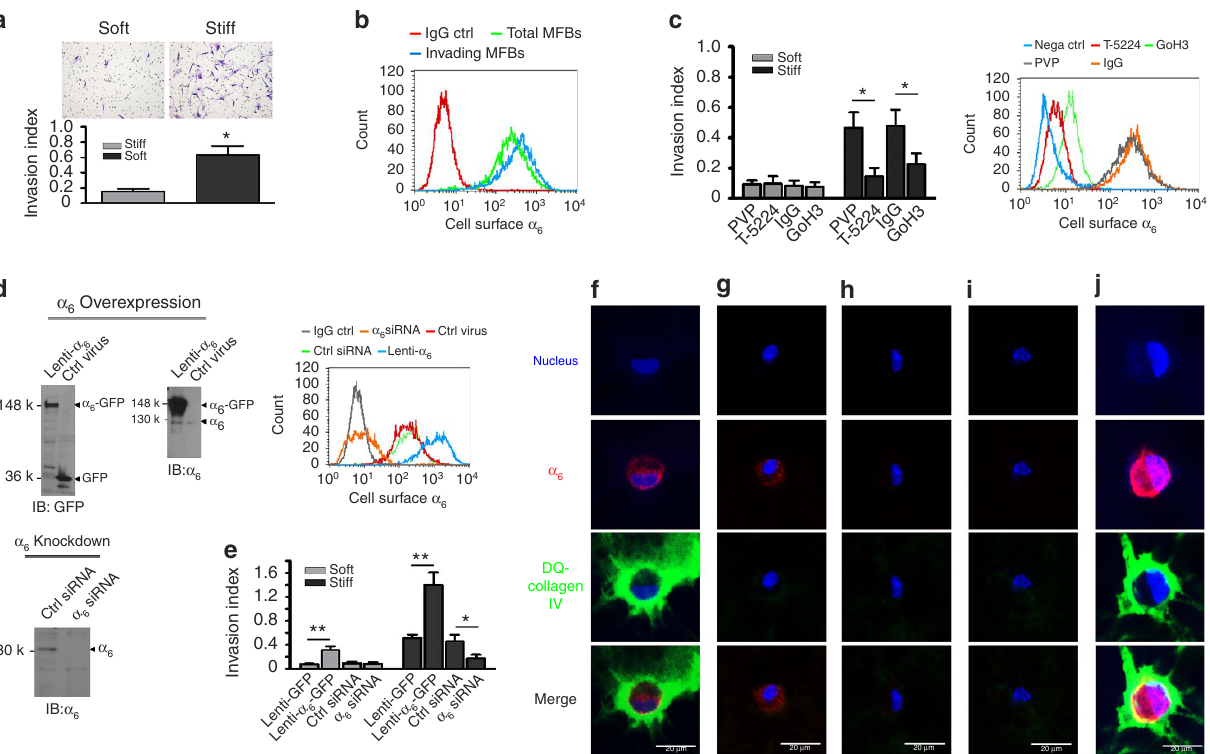
Figure 2 | a 6 Mediates matrix stiffness-dependent lung myofibroblast invasion into the BM. ( a ) The ability of IPF myofibroblasts cultured on soft versus stiff matrix to invade the BM was evaluated by Matrigel invasion assay. ( b ) a 6 -Expression on the cell surface of invading myofibroblasts versus total (myo)fibroblasts was evaluated by flow cytometry. ( c ) Effects of NKI-GoH3 and T-5224 on stiffness-regulated myofibroblast invasion into the BM. a 6 -Expression on the cell surface was evaluated by flow cytometry using FITC-labelled GoH3. PVP, a vehicle for T-5224; IgG, FITC-labelled isotype control IgG for NKI-GoH3; Nega ctrl, plain cells with no treatments and no incubation with FITC-labelled GoH3/IgG. ( d ) Overexpression of a 6 -GFP fusion protein by lentivirus and knockdown of a 6 by siRNA in cell lysates were determined by immunoblot and flow cytometry. ( e ) Effects of overexpression or knockdown of a 6 on stiffness-regulated myofibroblast invasion into the BM. ( f – j ) a 6 -expression (red) and proteolytic activation of DQ-collagen IV (green) in the absence ( f ) or presence of NKI-GoH3 ( g ), T-5224 ( h ), a 6 -siRNA ( i ) and Lenti- a 6 ( j ) were determined by confocal immunofluorescent microscopy. Nuclei (blue) were stained by DAPI. Results are the means ± s.d. of at least three separate experiments; * P o 0.05, ** P o 0.01; one-way analysis of variance. Scale bar, 20 m (Fig. 2g), inhibition of mechano-induction of a 6 -expression Fig. 5c) and IPF lung myofibroblast invasion into BM matrices by T-5224 (Fig. 2h), and knockdown of a 6 -expression with a 6 -specific siRNA (Fig. 2i) inhibited pericellular proteolysis of collagen IV. Overexpression of a 6 -integrin enhanced pericellular proteolysis of collagen IV (Fig. 2j). The IgG isotype control antibody, PVP and scrambled control siRNA had no effects on proteolysis of collagen IV (Supplementary Fig. 4).